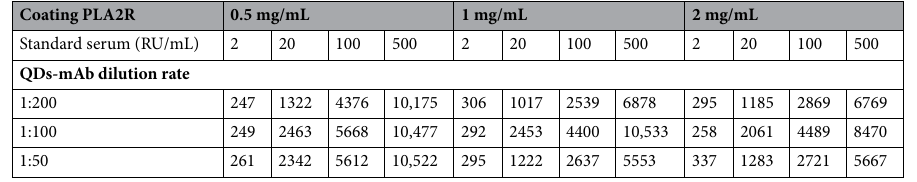
Table 2. Optimized conditions for the coated PLA2R and the QD-labeled antibody. Values are fluorescence at 615 nm, determined in the checkerboard titration test.